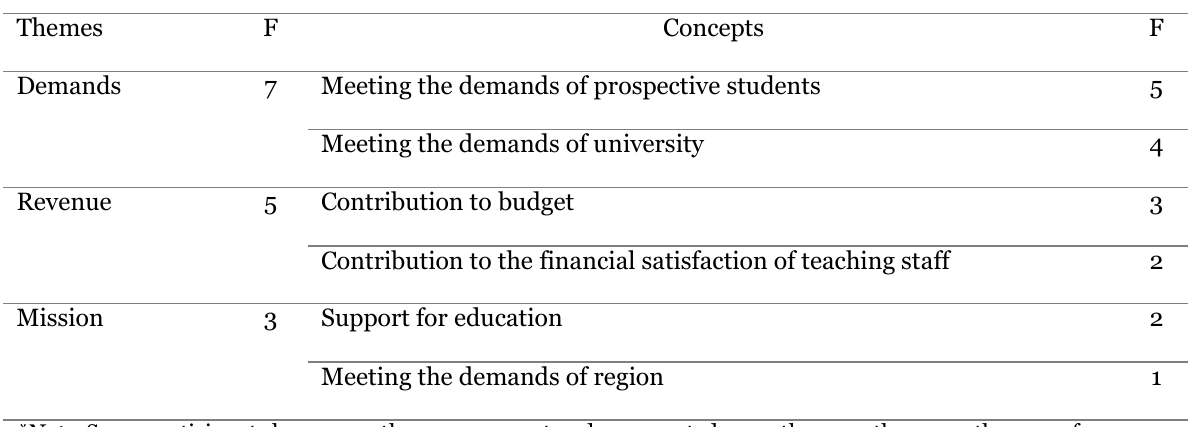
Administrators' Conceptions and Frequencies about the Motives of Offering Online Bachelor's Degree Completion Programs